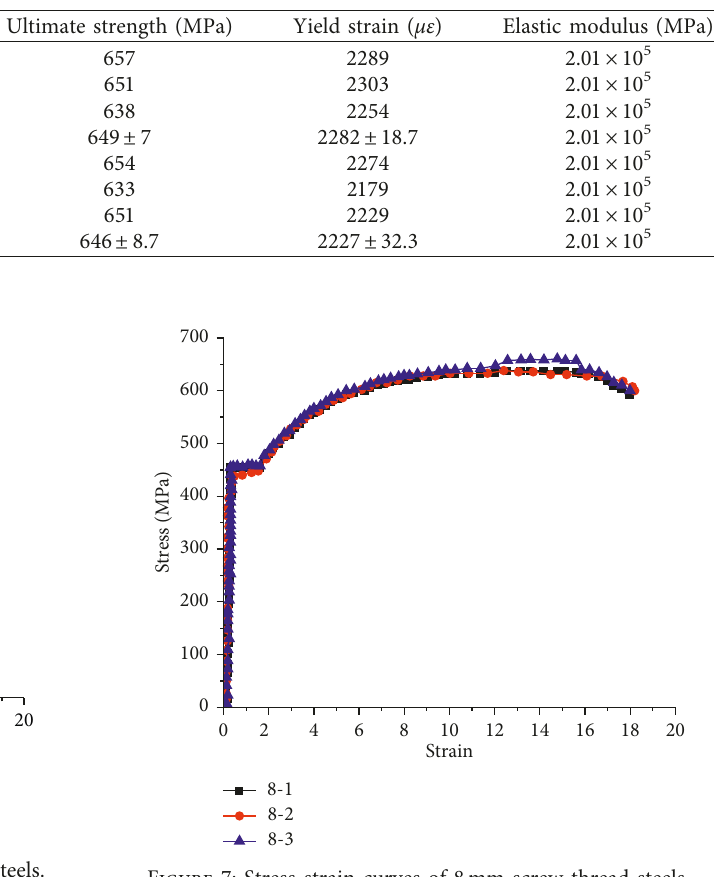
Table 5: Properties of screw-thread steels.